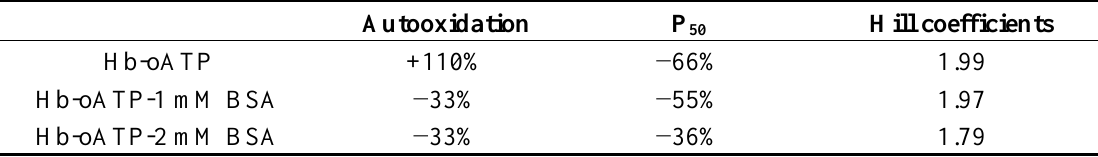
Table 2. Autooxidation rates and P values expressed in percentage increases relative to 50 nHb, and Hill coefficients for Hb-albumin copolymers